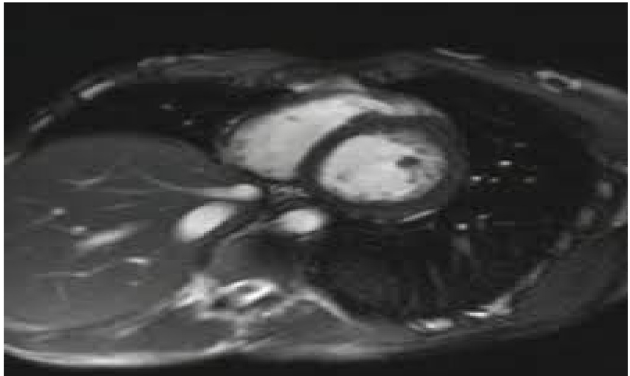
Fig. 6. Heart image taken by an